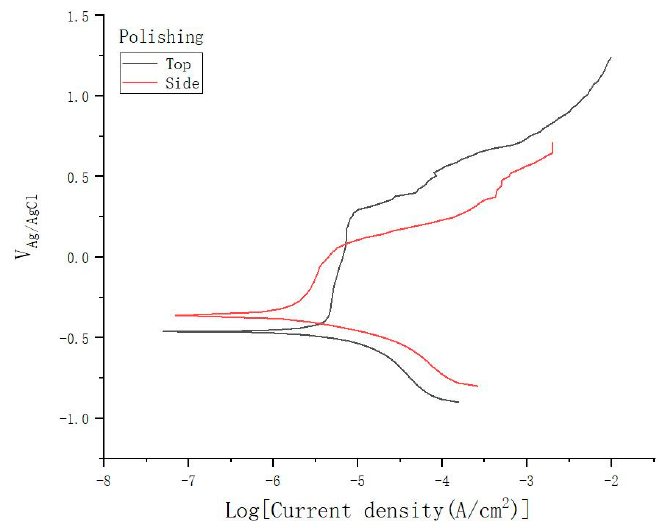
Figure 8. The polarization curve of the polished samples.